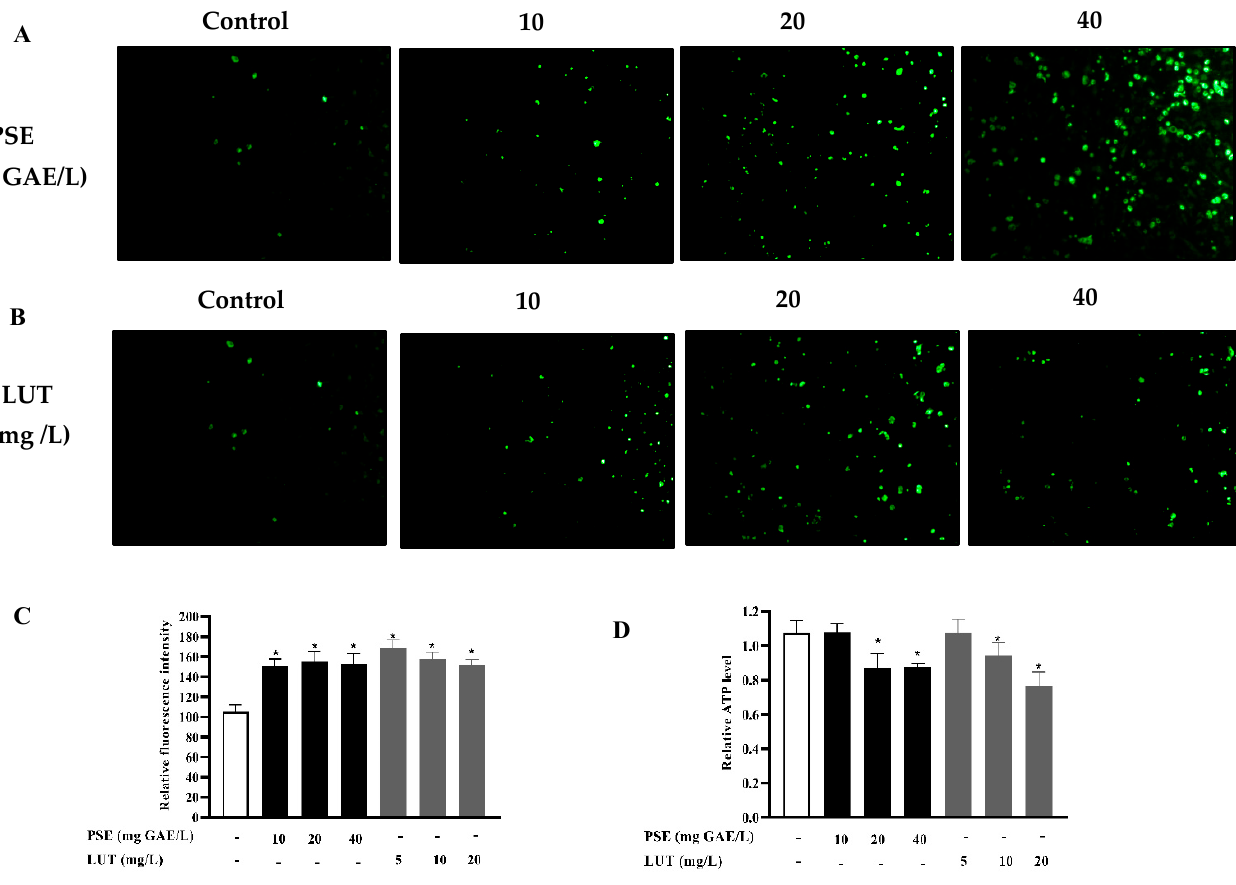
Figure 8. The effect of PSE and LUT on the mitochondrial biogenesis of fully differentiated 3T3-L1 adipocytes after 48 h. ( A ) Mito Tracker Green staining of fully differentiated 3T3-L1 adipocytes treated with different PSE concentrations (0 mg/L, 10 mg/L, 20 mg/L and 40 mg/L) at 200 × magnification. ( B ) Mito Tracker Green staining of fully differentiated 3T3-L1 adipocytes treated with different LUT concentrations (0 mg/L, 5 mg/L, 10 mg/L and 20 mg/L) at 200 × magnification. Scale bar = 200 µ m. ( C ) Quantified via the fluorescence intensity measuring of the mitochondrial mass. ( D ) The intracellular ATP level. The data are presented as the mean ± SD from three independent experiments. * Significant differences are indicated by p < 0.05.